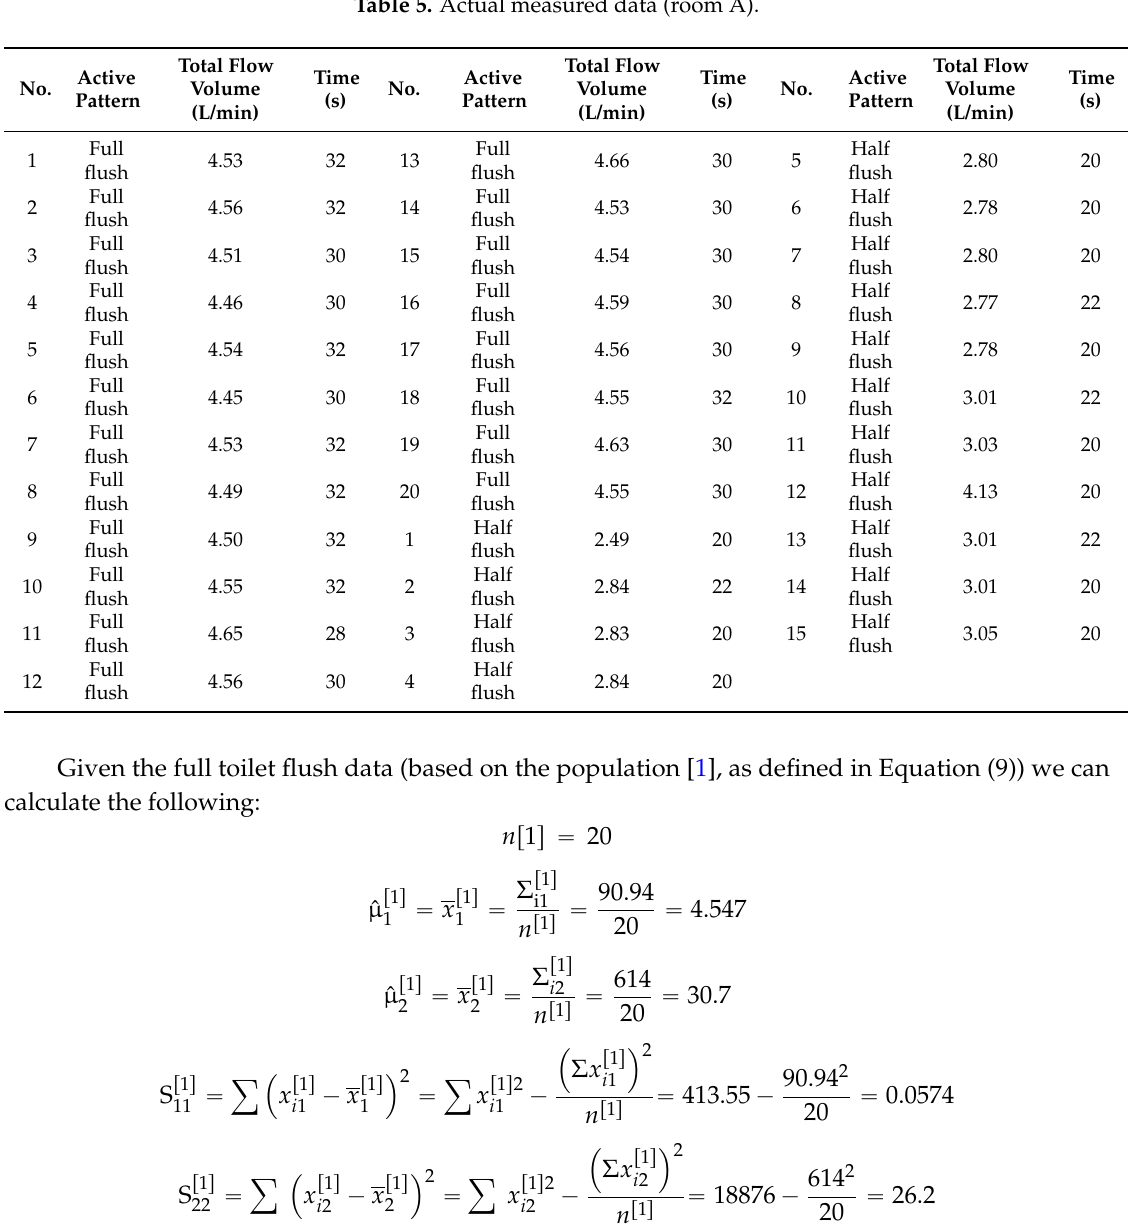
Table 5. Actual measured data (room